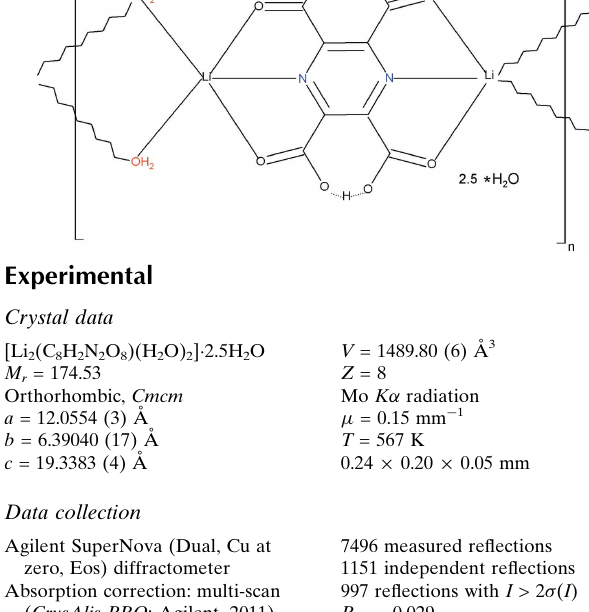
Data collection